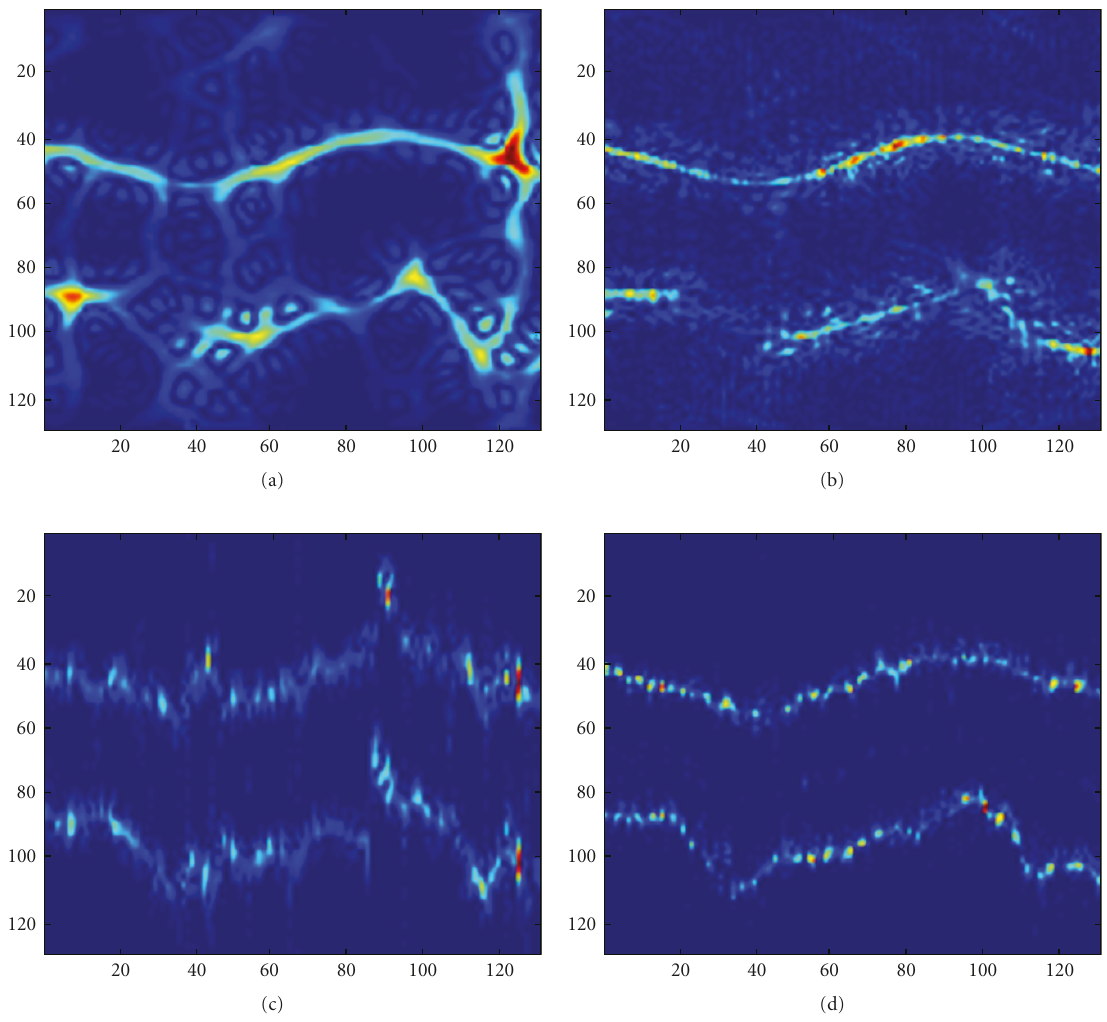
Figure 4: Time-frequency representation for multicomponent signal x ( n ) by using (a) the standard SM, (b) the L-estimate SM, (c) the standard CTD N = 4 , and (d) the L-estimate RCTD N = 4 .